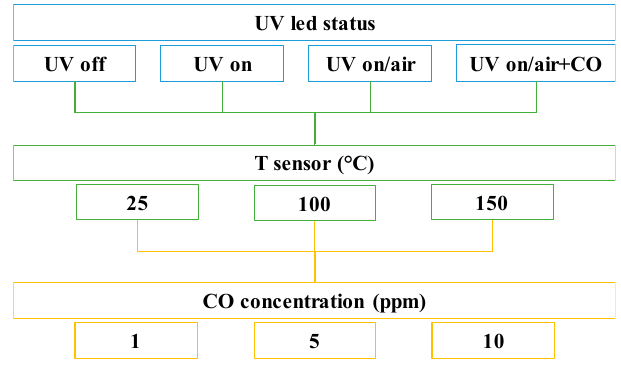
Figure 1. Diagram showing the experimental conditions used.